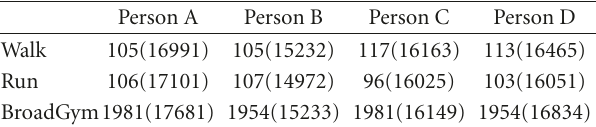
Table 1: The number of frames and average number of vertices (shown in parenthesis) in TVM